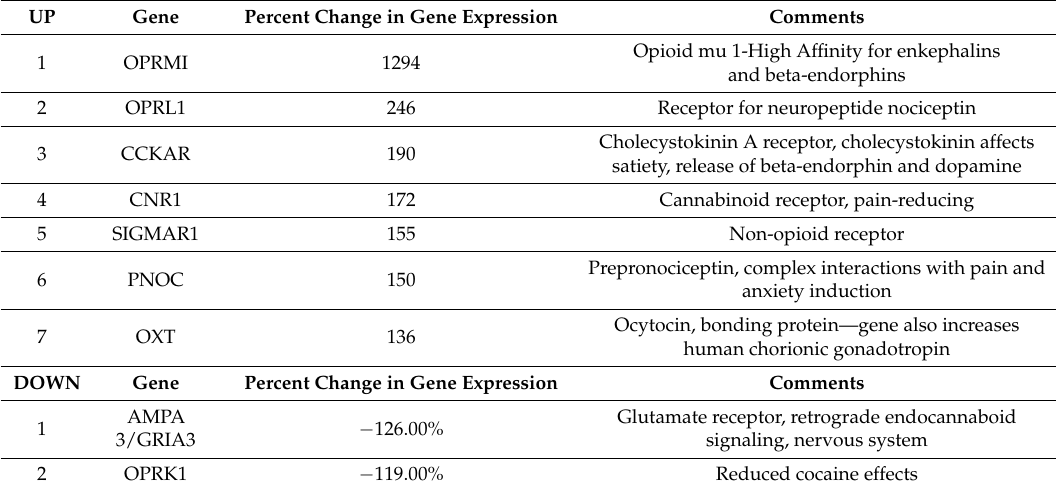
Table 3. GHK and Genes Associated with